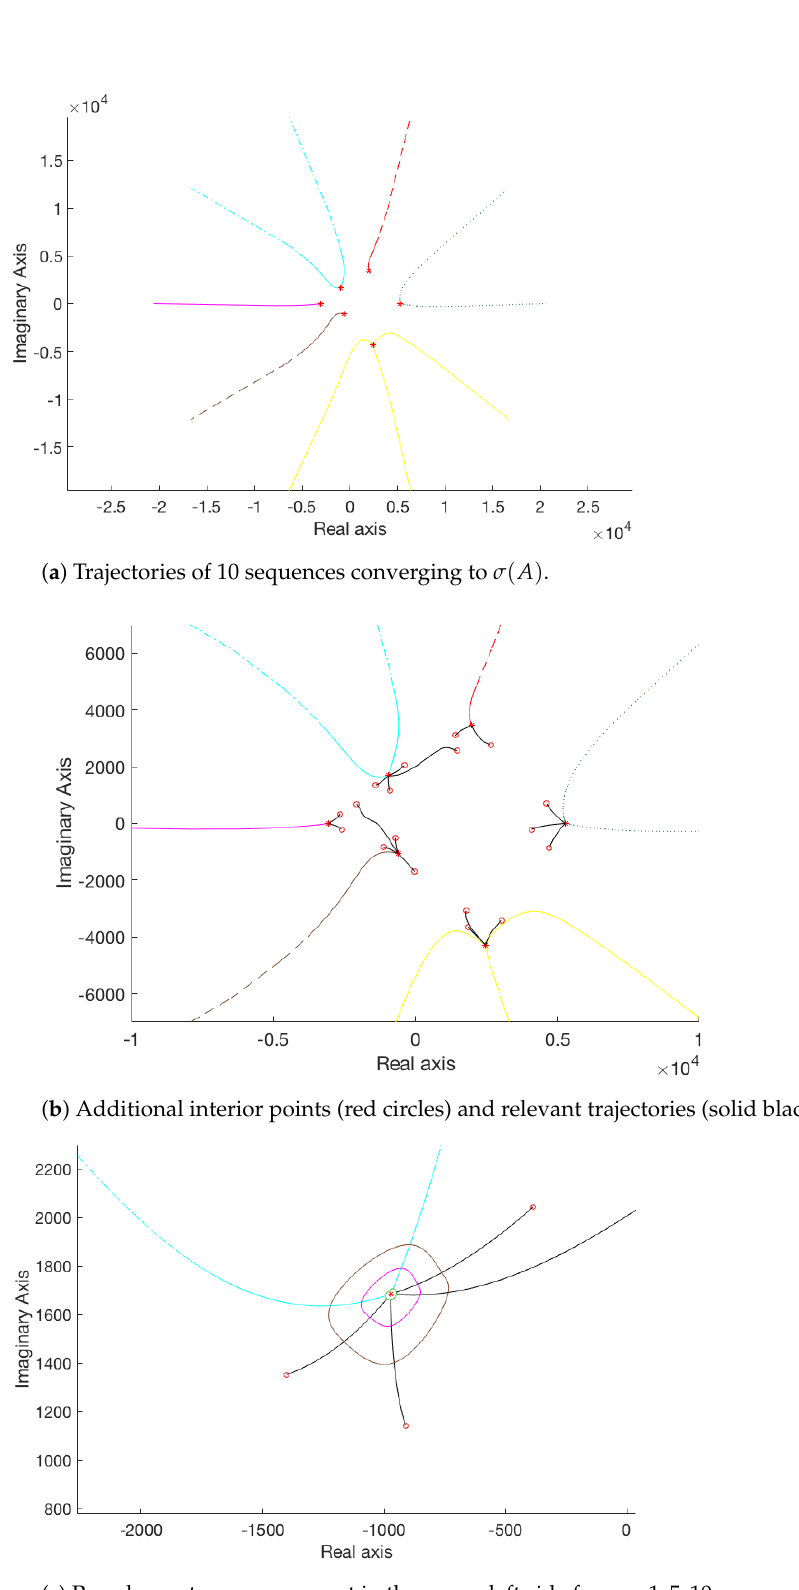
Figure 1. Pseudospectrum computation for random A ∈ C 6 × 6 with spectral gaps, using 10 ini- tial